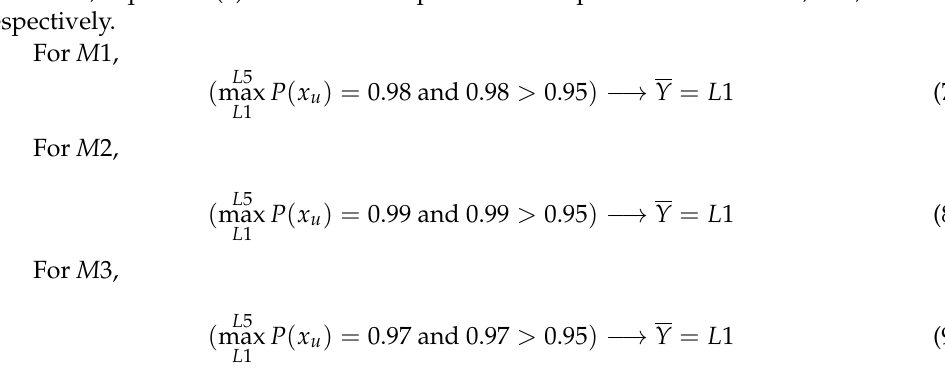
Table 1. Prediction results for a single observation x u using three decision